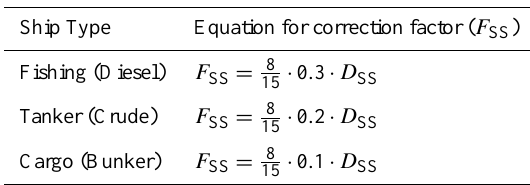
Table D4. Subtracting correction factor ( F SS ) based on spill site used, in function of ship type and distance between spill site and shoreline ( D SS )